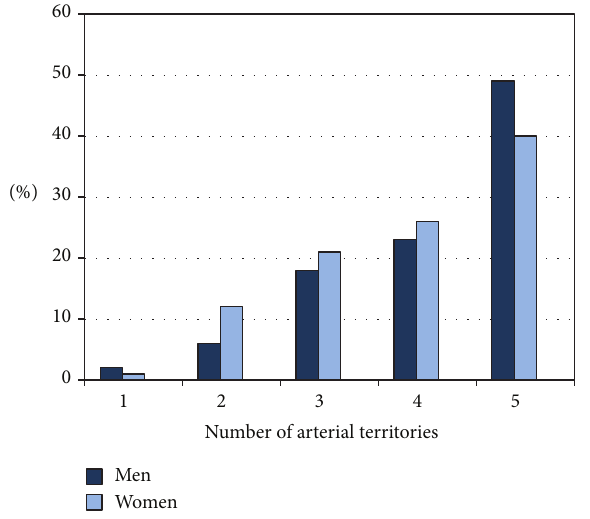
Figure 1: Number of arterial territories (intracranial, carotid, coronary, renal, and aorta) with atherosclerosis according to gender.